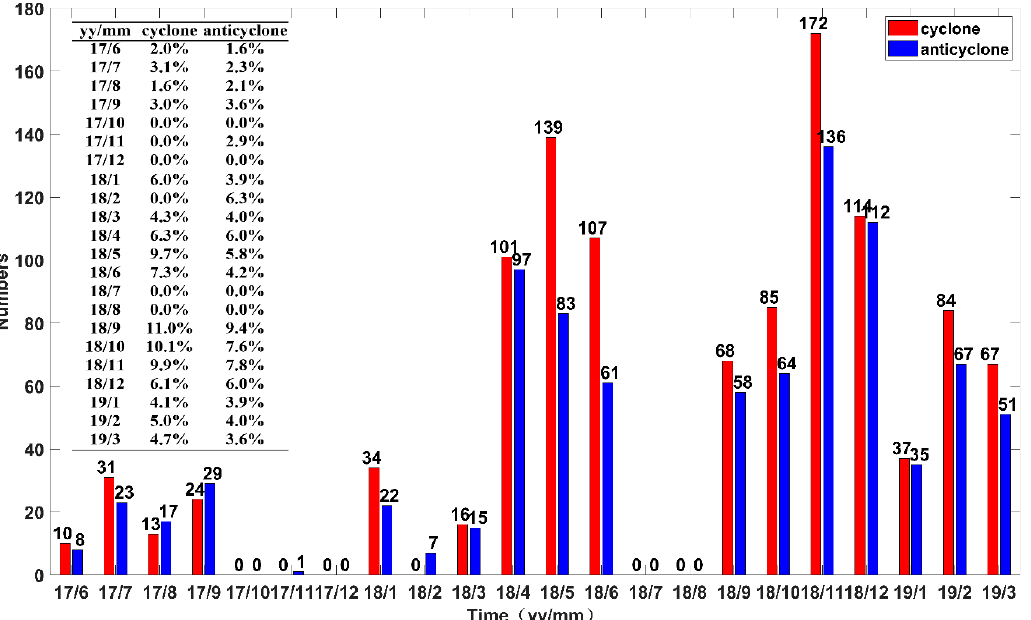
Figure 7. Histogram of the monthly distribution of eddies identified by HFR-derived current fields. The table shows the ratio of the cyclonic (anticyclonic) eddy number to the total observation records each